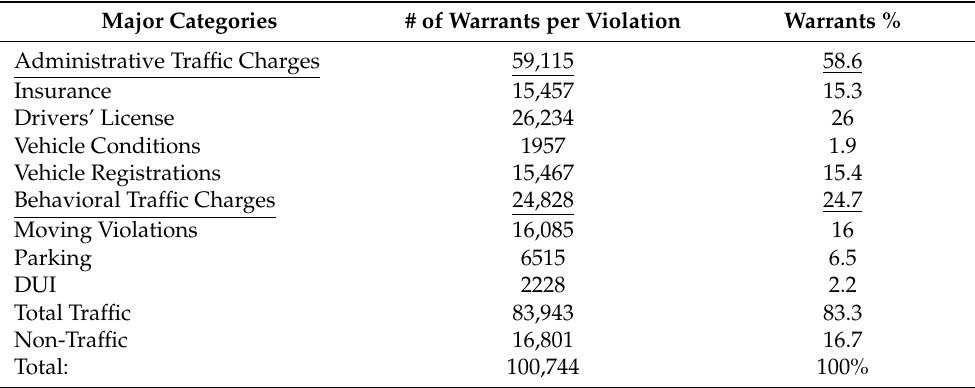
Table 2. Behavioral vs. Administrative Traffic Charges: 8 Categories.